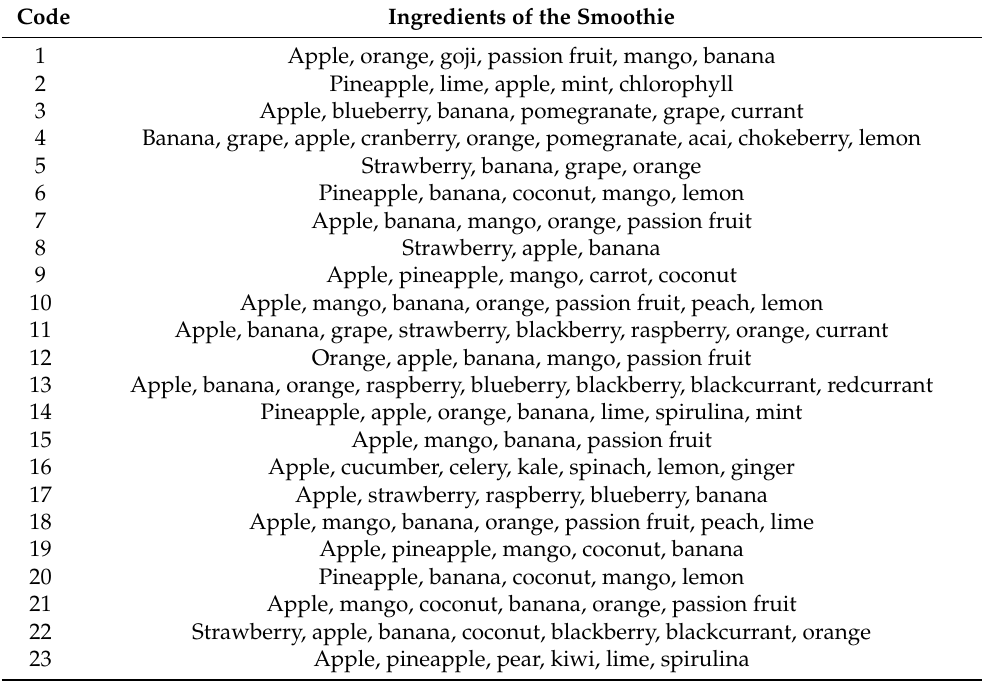
Table 6. List of the smoothies analyzed with their code name and their ingredients.